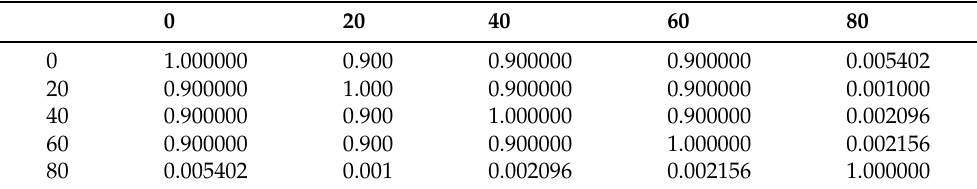
Table 3. Multiple Comparison Test (Tukey’s method) performed on clogging level groups from Pressure